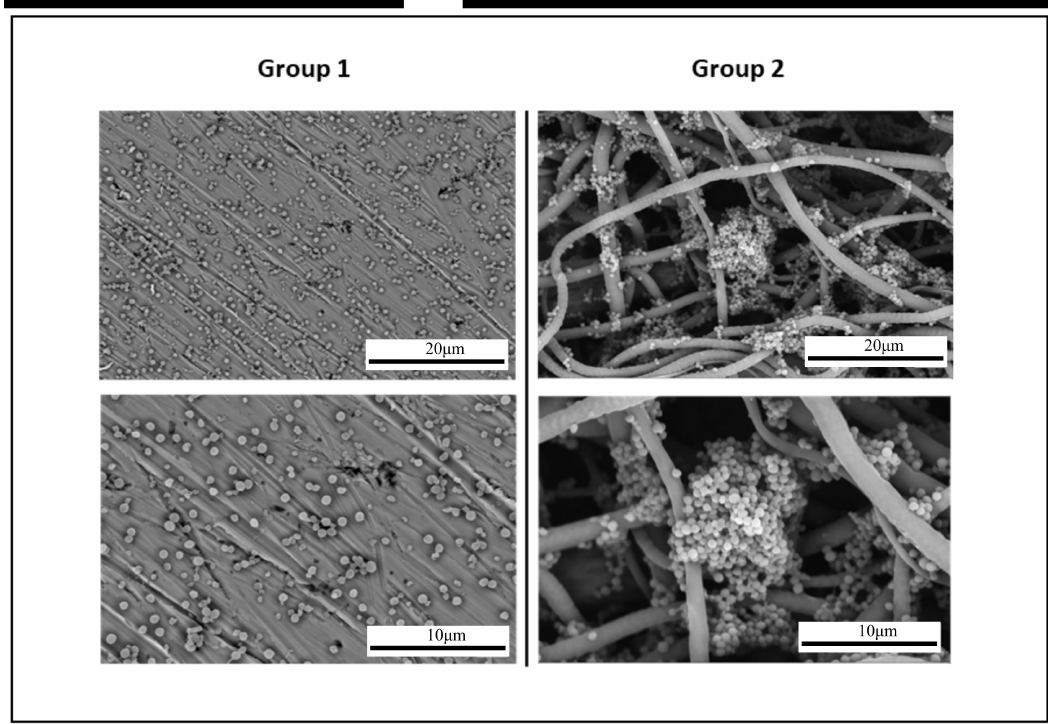
and Group 2 – Nanotubes of TiO 2